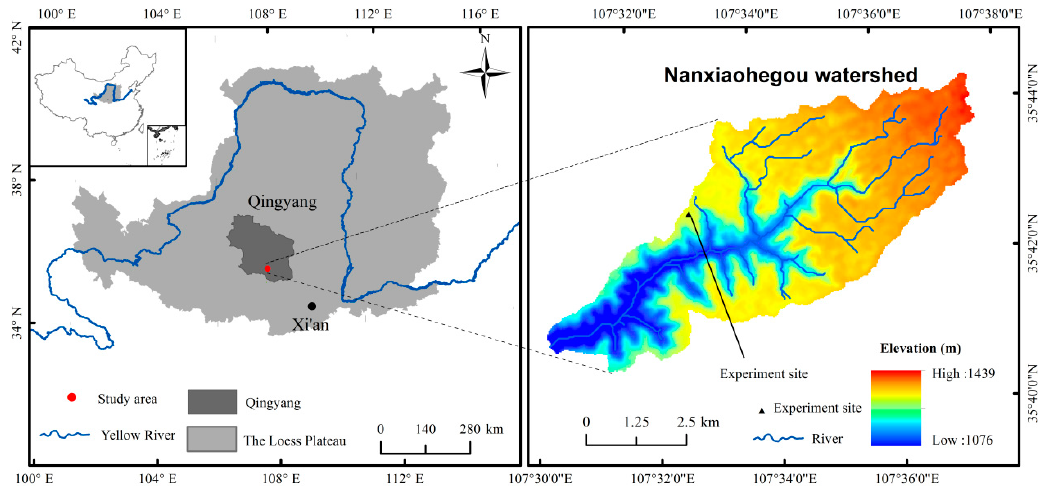
Figure 1. Location of the Nanxiaohegou watershed.